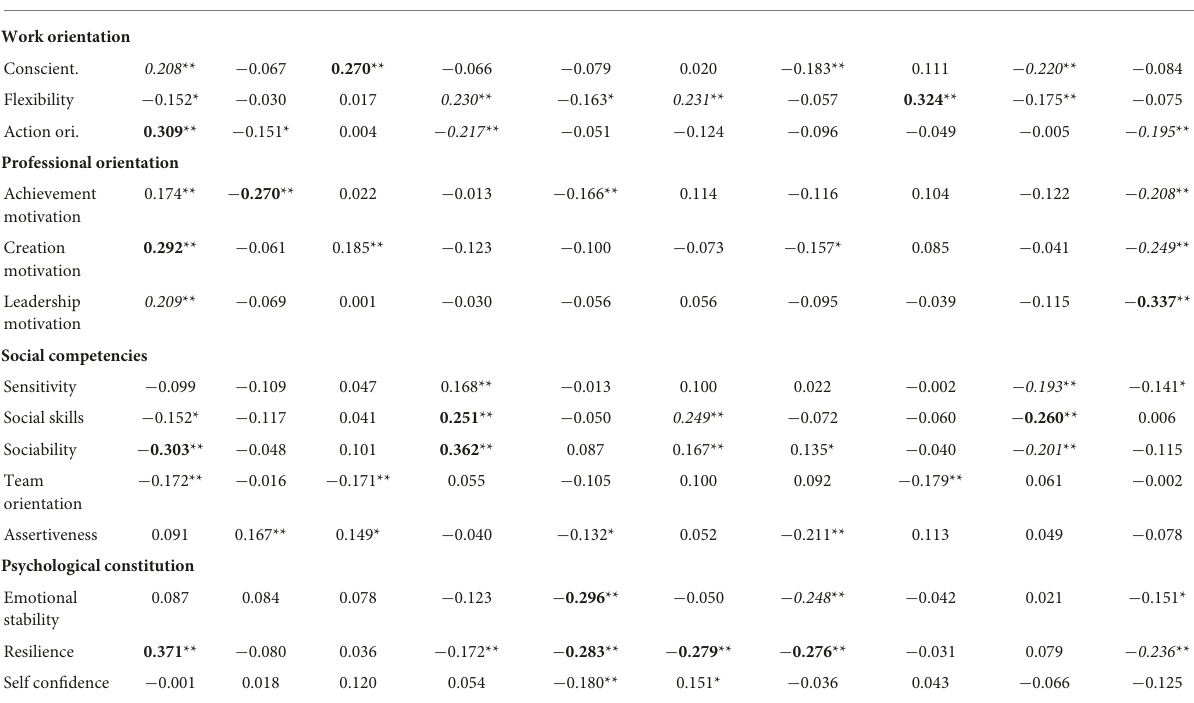
TABLE 2 Correlations of CPS and personality disorders with work-related personality manifestations as assessed with the BIP. Variable CPS